Question: Describe this figure in one sentence.
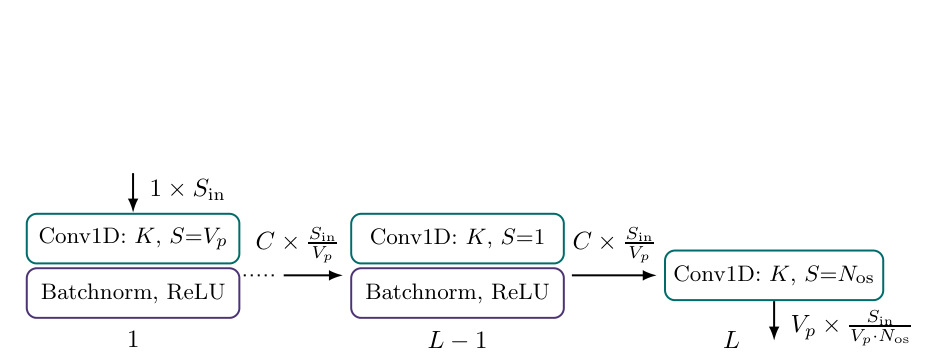
Answer: Topology template of the equalizer CNN. The feature map dimensions are given next to the arrows, where the ﬁrst dimension corresponds to the number of channels and the second one to the width.